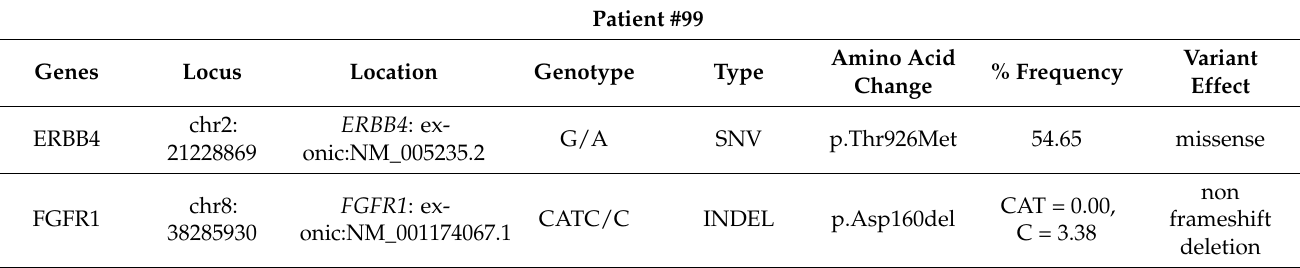
Table 2. Mutations detected in CTCs from patient number 99’s blood sample by NGS.